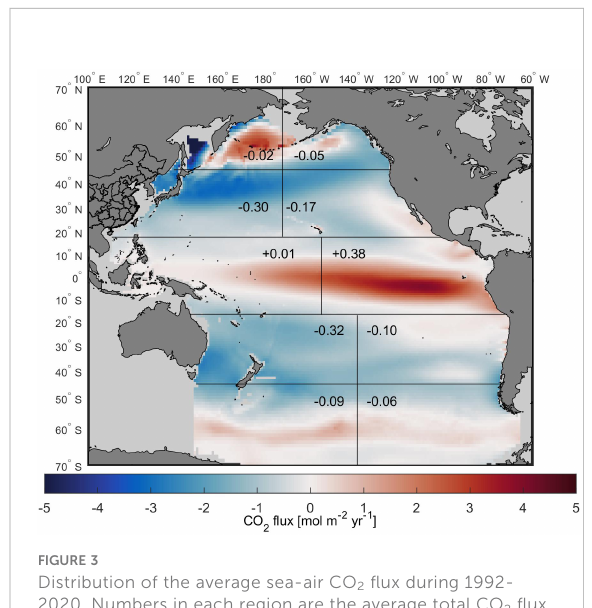
FIGURE 3 Distribution of the average sea-air CO 2 fl ux during 1992- 2020. Numbers in each region are the average total CO 2 fl ux (in PgC yr -1 ), separated by the 174°W, 158°W, and 139°W longitude boundaries. The latitude boundaries are 44°N, 18° N, 18°S, and